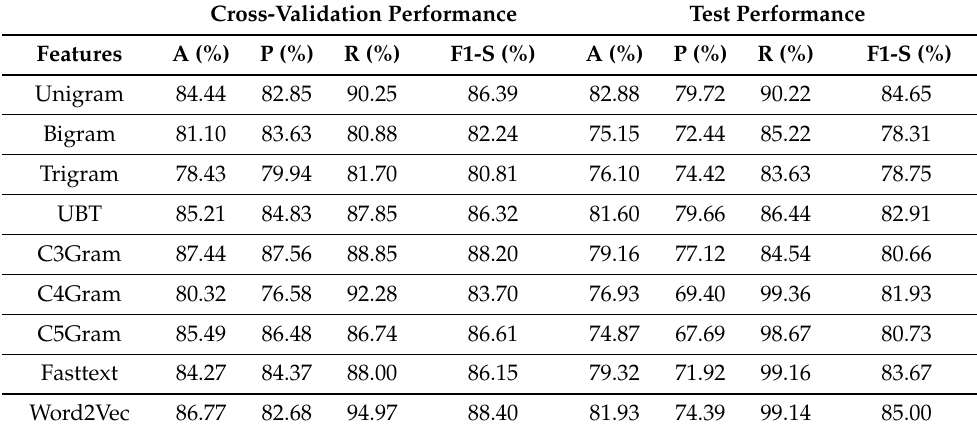
Table 10. Performance of K-Nearest Neighbor (KNN) machine learning